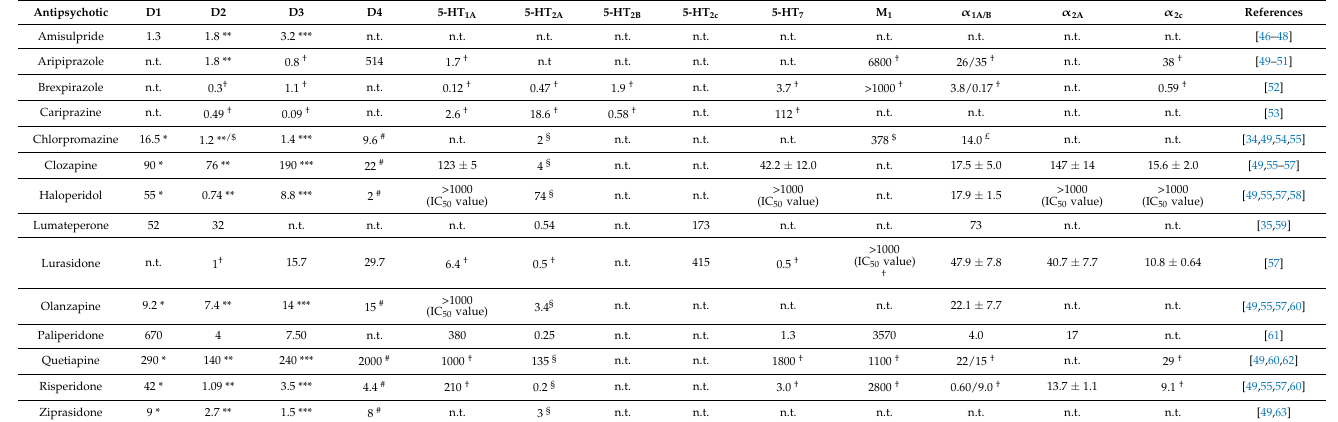
Table 2. Antipsychotic dissociation constants (nM) at